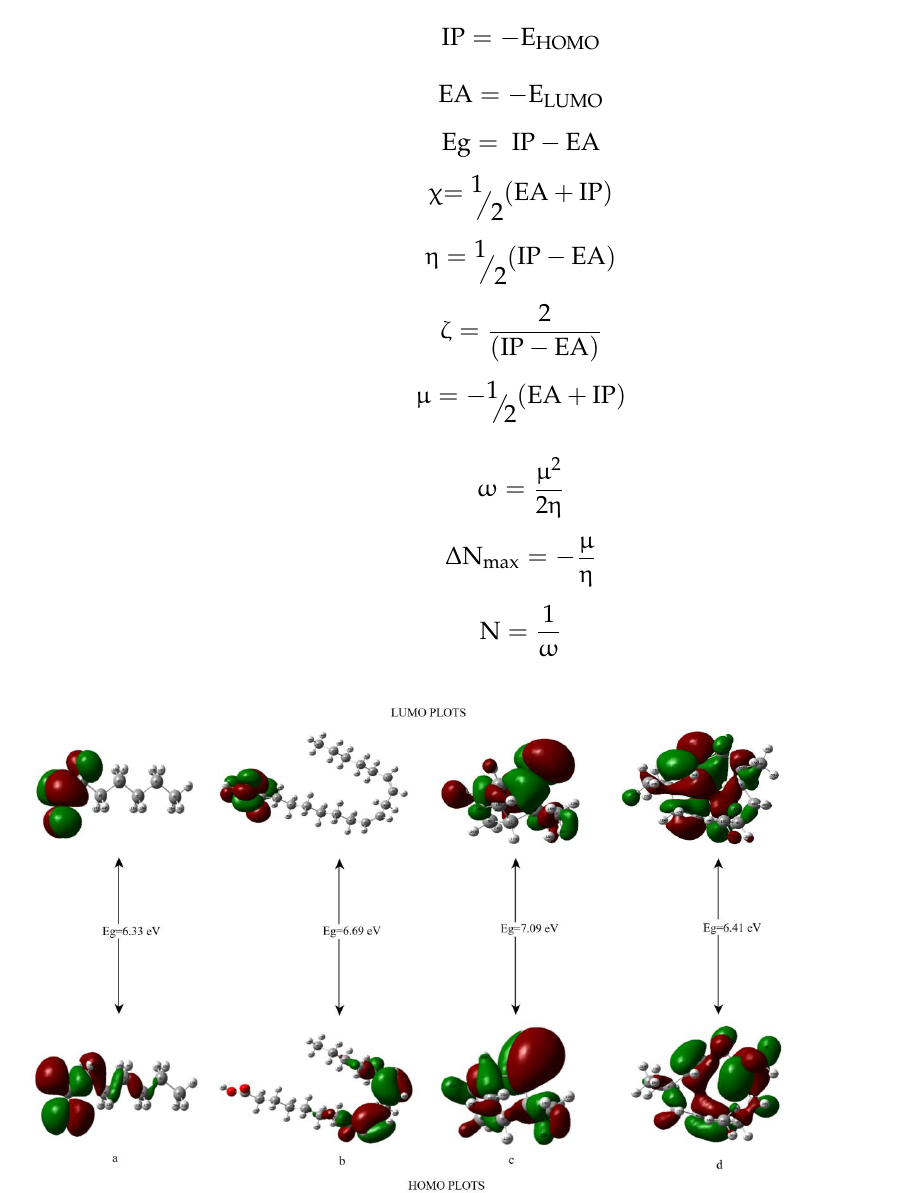
Table 3. Some electronic properties of studied molecules (a – d) calculated by the DFT/B3LYP method in the gas phase and water *. Parameters